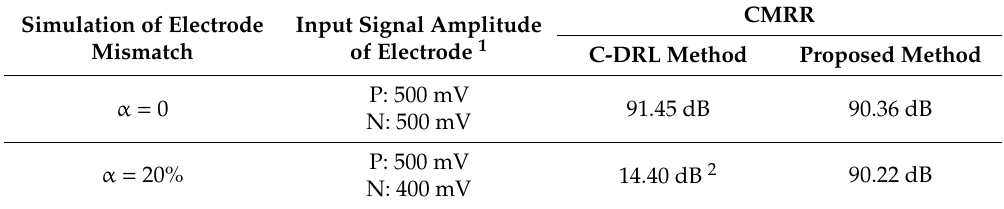
Table 1. CMRR comparison of circuits using proposed method and C-DRL method. Simulation of Electrode